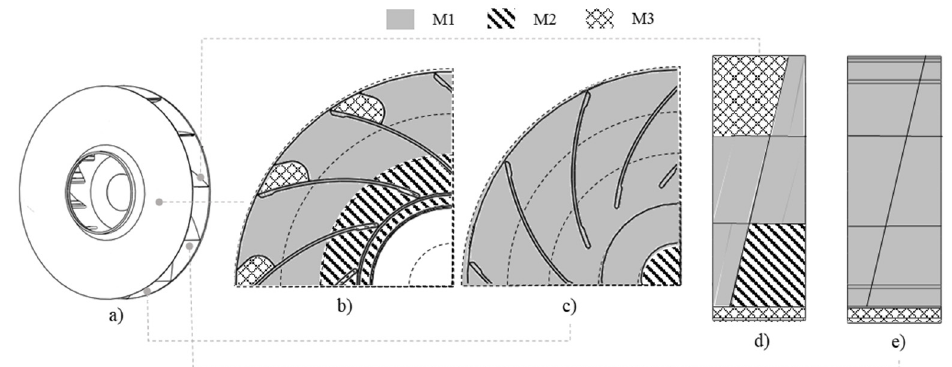
Figure 8. Optimized configuration of the wear-resistant plates on the rotor: ( a ) view of the rotor, ( b ) shroud, ( c ) hub, ( d ) blade pressure side and ( e ) blade suction side. ( b ) shroud, ( c ) hub, ( d ) blade pressure side and ( e ) blade suction